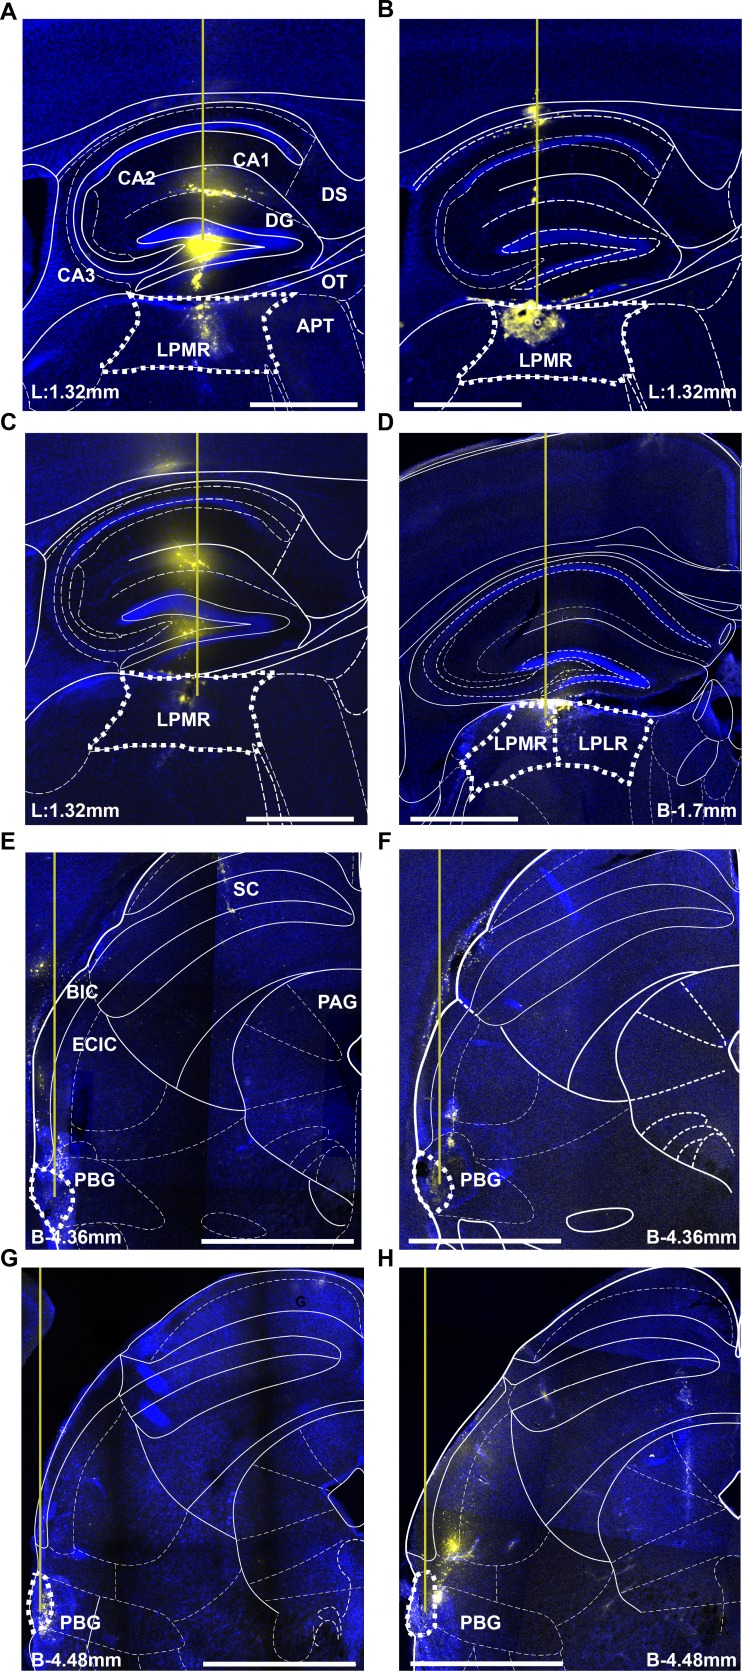
HSV injection sites of pulvinar and parabigeminal nucleus.(A–D) Histological section of four examples pulvinar injection sites. The pipette (indicated as a yellow line) was coated with a fluorescent dye (DiD) and the fluorescent signal coincides with the location of the pulvinar (LP). A-C were from sagittal sections and D was from coronal section. Scale bar = 1 mm. (E–H) Histological section of four example prabigeminal nucleus injection sites. All of them were from coronal sections. Scale bar = 1 mm.